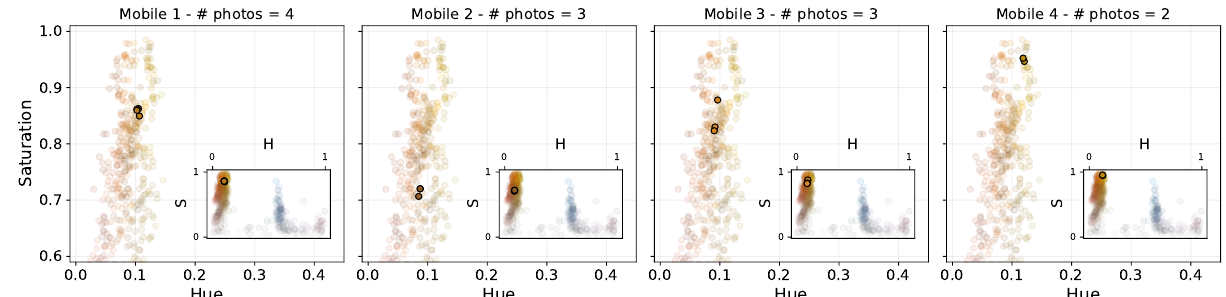
Figure 5. Scatter plots for the colours extracted from a set of photos taken in an area where all the lamps were verified to be of the same type (HPS). Each panel corresponds to the photos taken by a different device. The shaded points are the colours extracted from the photos of the whole human-verified database, for comparison.